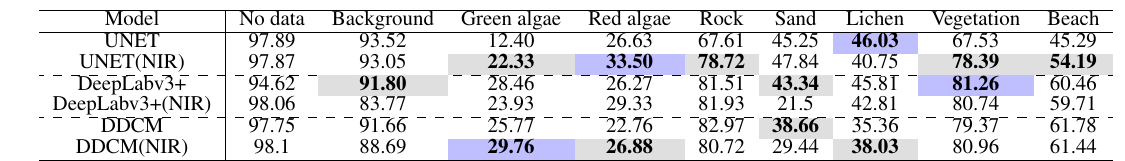
Table 6. Class-wise IU scores. Noticeable improvement ( > 5%) between the same model type is highlighted in gray. The best score of selected classes is highlighted in